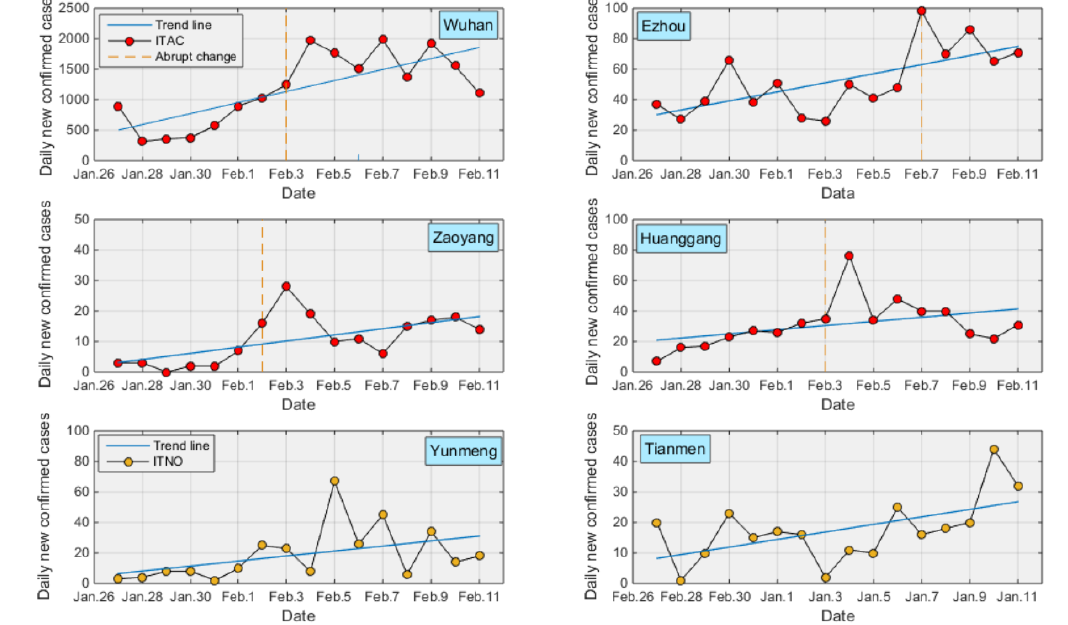
Figure 4. The change curve of these areas with the ITAC or ITNO patterns.